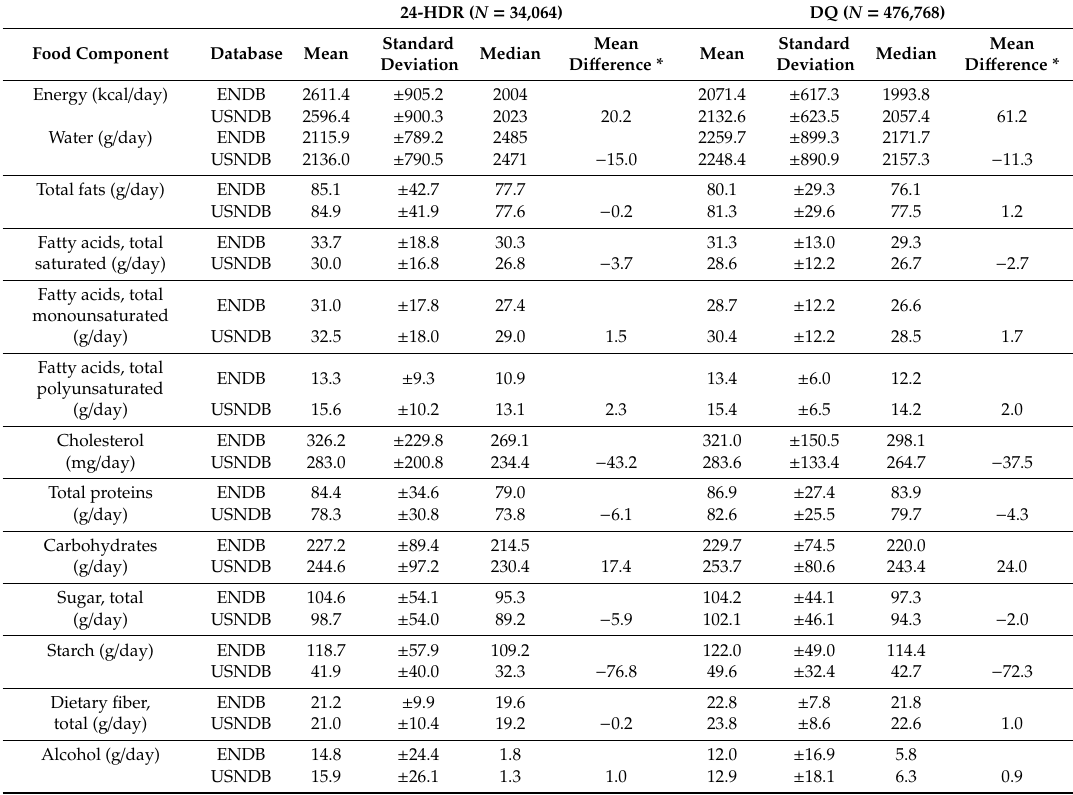
Table 2. Mean, standard deviation and median of dietary intakes of 28 nutrients estimated by the U.S. nutrient database (USNDB) and the EPIC nutrient database (ENDB) and their absolute mean di ff erence in nutrient intake, reported for the 24-hour dietary recall data (24-HDR) and the dietary questionnaire data